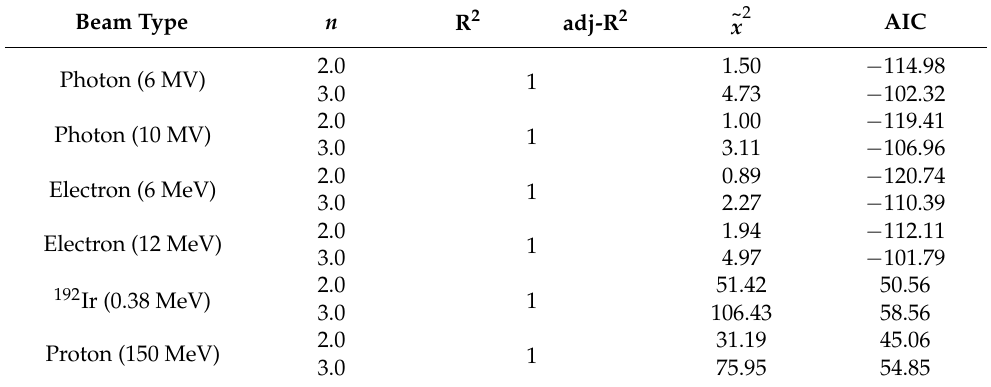
Table 5. Fitting analysis in terms of R 2 , adj-R 2 , (cid:101) x 2 and AIC for standard Gafchromic ™ EBT3 films.